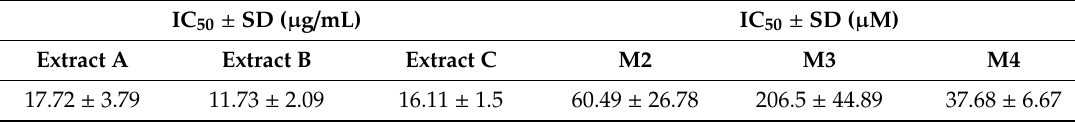
Table 4. Nitrites production inhibitory activity (IC 50